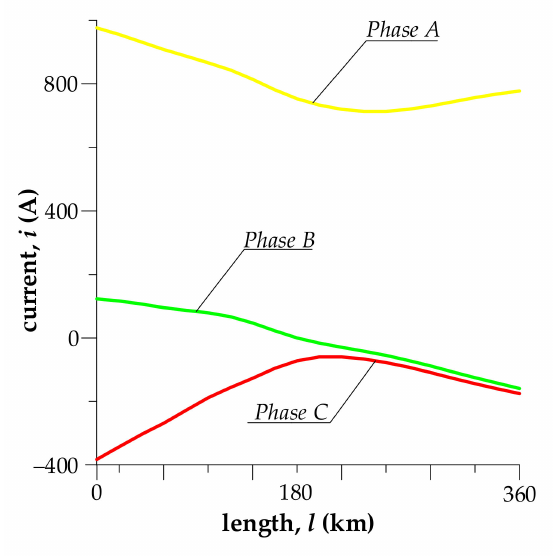
Figure 6. Space distribution of current changes across the line at t = 0.004 s.